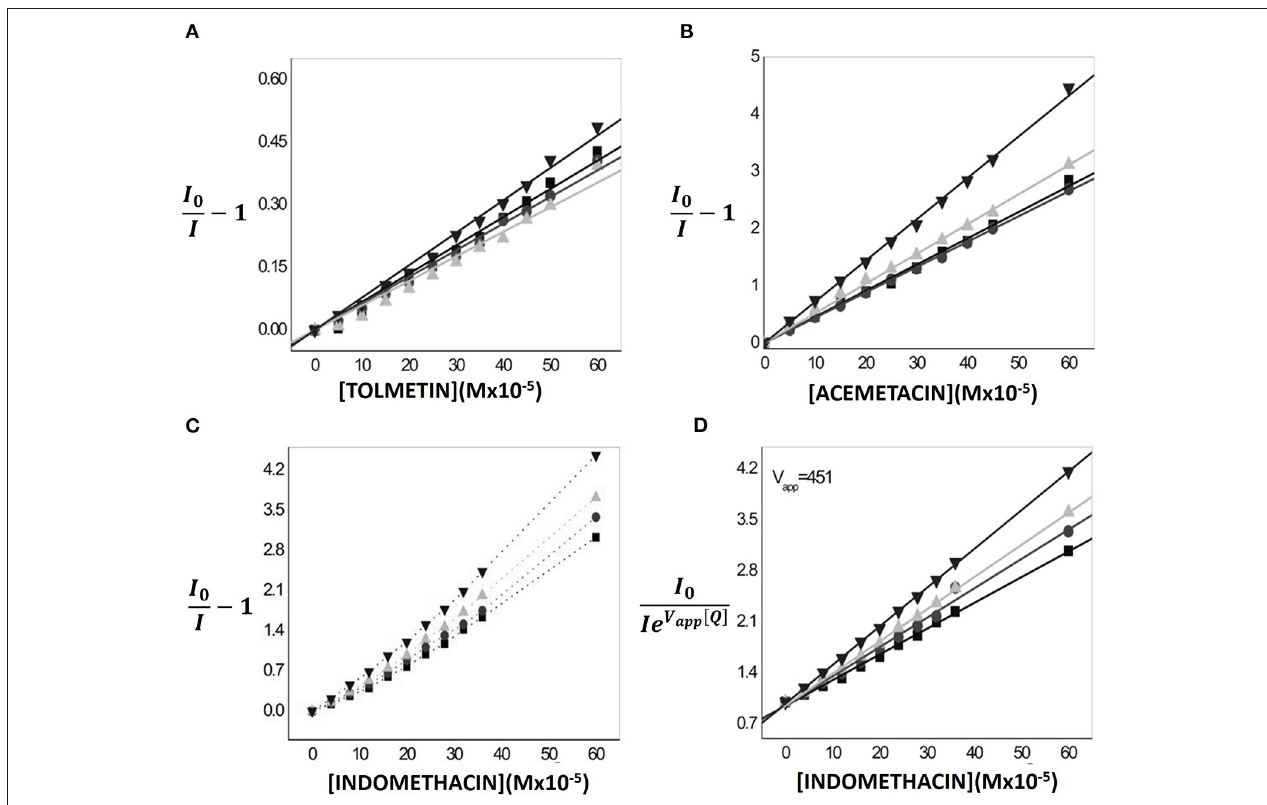
FIGURE 7 | Variations of relative fluorescence intensity (I/I 0 ) at 25.0 ◦ C of 2-AS ( H ), 6-AS ( ) 9-AS ( ) and 12-AS ( (cid:4) ) probes incorporated in MLVs (500 µ M) as function of increasing concentrations of Tolmetin (A) Acemetacin (B) and Indomethacin (C) in Hepes buffer pH = 7.4 and I = 0.1M. Stern-Volmer linear regressions were also aplied to evaluate the quenching efficiency promoted by Tolmetin (A) , Acemetacin (B) , and Indomethacin (D) .